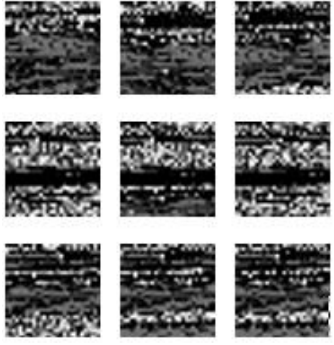
Figure 5. Example of traffic image.